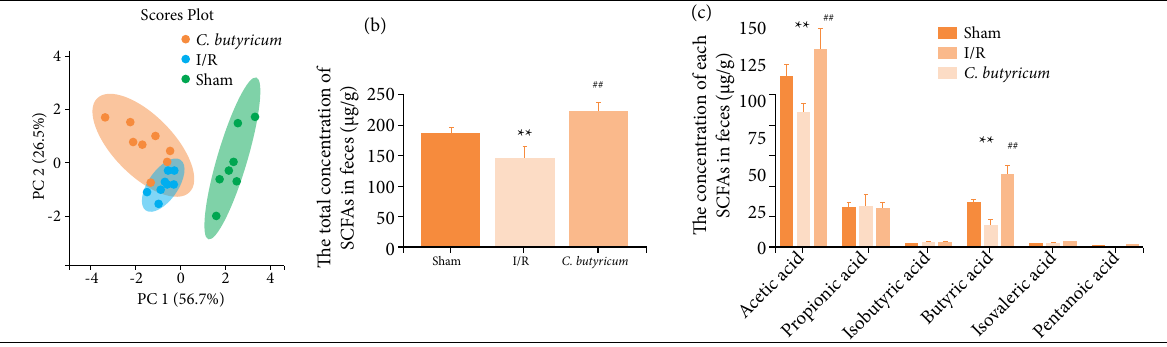
Figure 5 - The SCFAs’ profiles in the hepatic tissue from the experimental groups’ feces. (a) PCA of SCFAs; (b) The total concentration of SCFAs in feces; (c) The concentrations of each SCFA in feces.